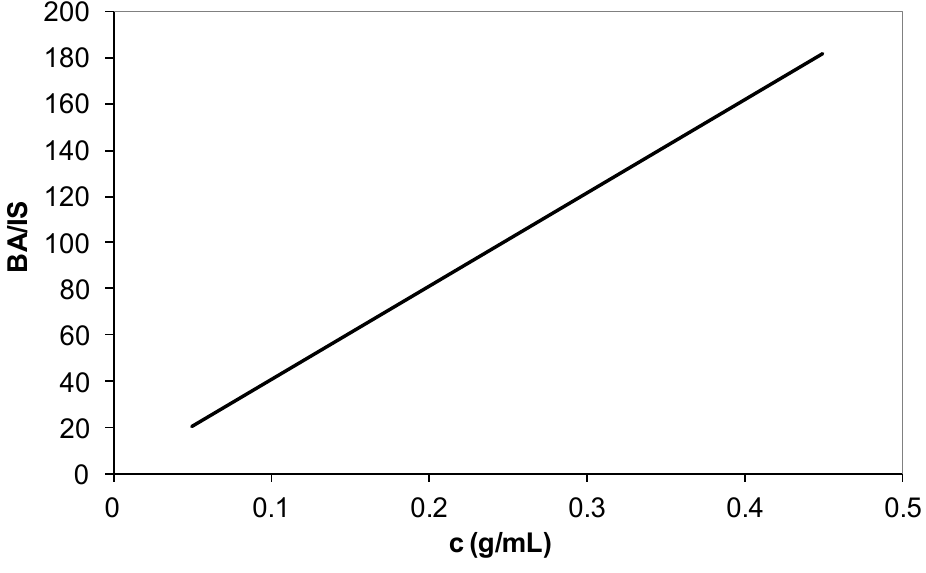
Figure 10. Calibration curve of butyl acrylate (BA) comonomer. IS: Internal standard.